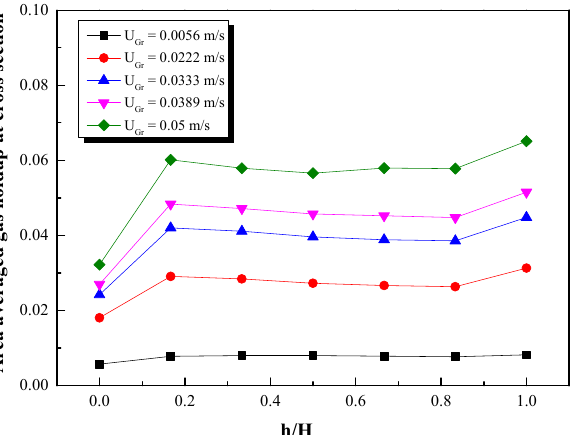
Figure 6. Area-averaged gas holdup at different cross sections for various 𝑈 (cid:3008)(cid:3045) at a total column height of 15 m.